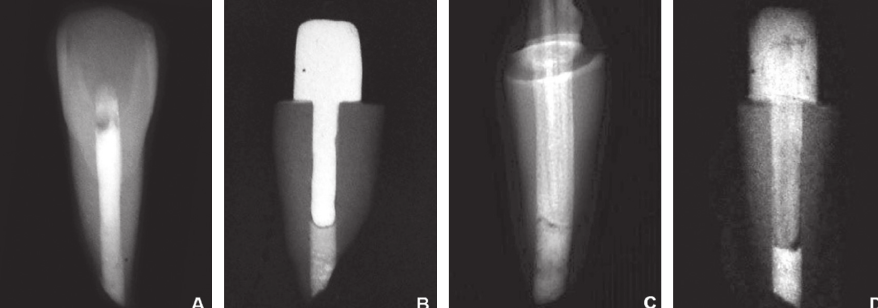
Figure 1: (a) Radiograph indicating tooth prepared with apical plug of MTA and obturation of remaining root embedded in self cure acrylic resin. (b) Radiograph after cementation of cast metal post and core. (c) Radiograph after cementation of customized composite post. (d) Radiograph after cementation of fiber post and core